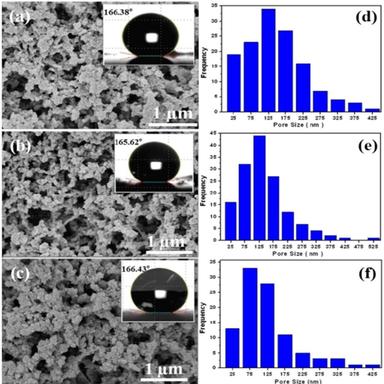
FESEM, the corresponding contact angle images and pore size distributions of the CTAB-modified PMSQ aerogels with C/M molar ratios of (a, d) 0.001, (b, e) 0.002 and (c, f) 0.004. Reprinted with permission from Ref. .